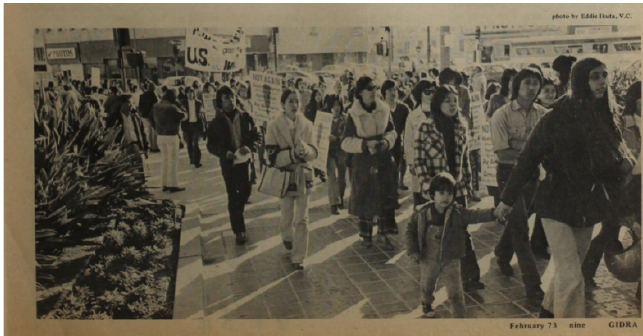
FIGURE 3. PHOTOGRAPH FROM GIDRA DEPICTING COMMUNITY ACTIVISM IN